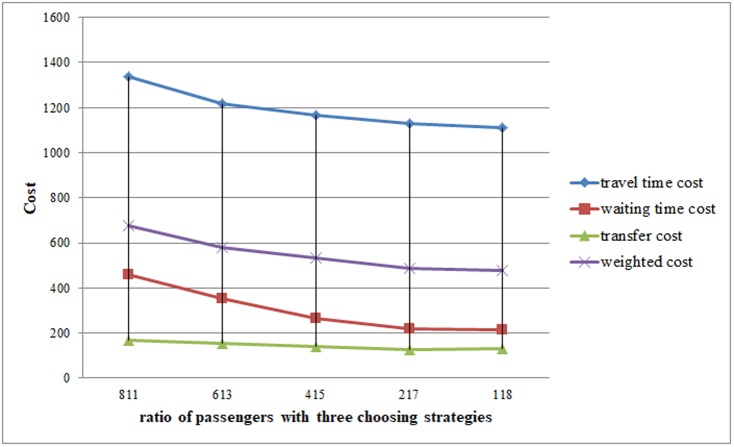
Results of experiments with different ratio of passenger under three choosing methods (811 in horizontal axis is defined as γFI = 0.8, γOAT = 0.1, γIFS = 0.1).